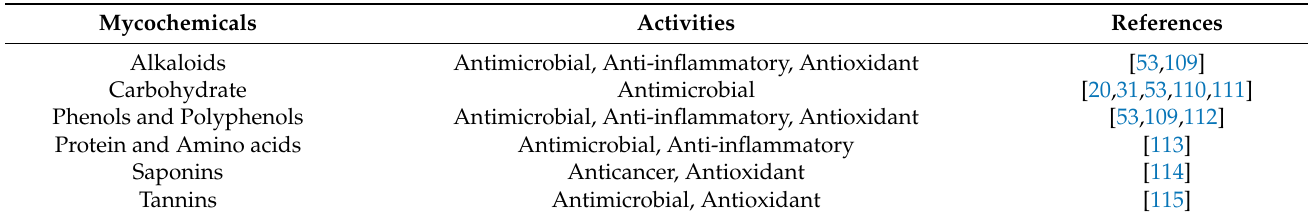
Table 3. Mycochemical analysis and activities in Agaricus bisporus